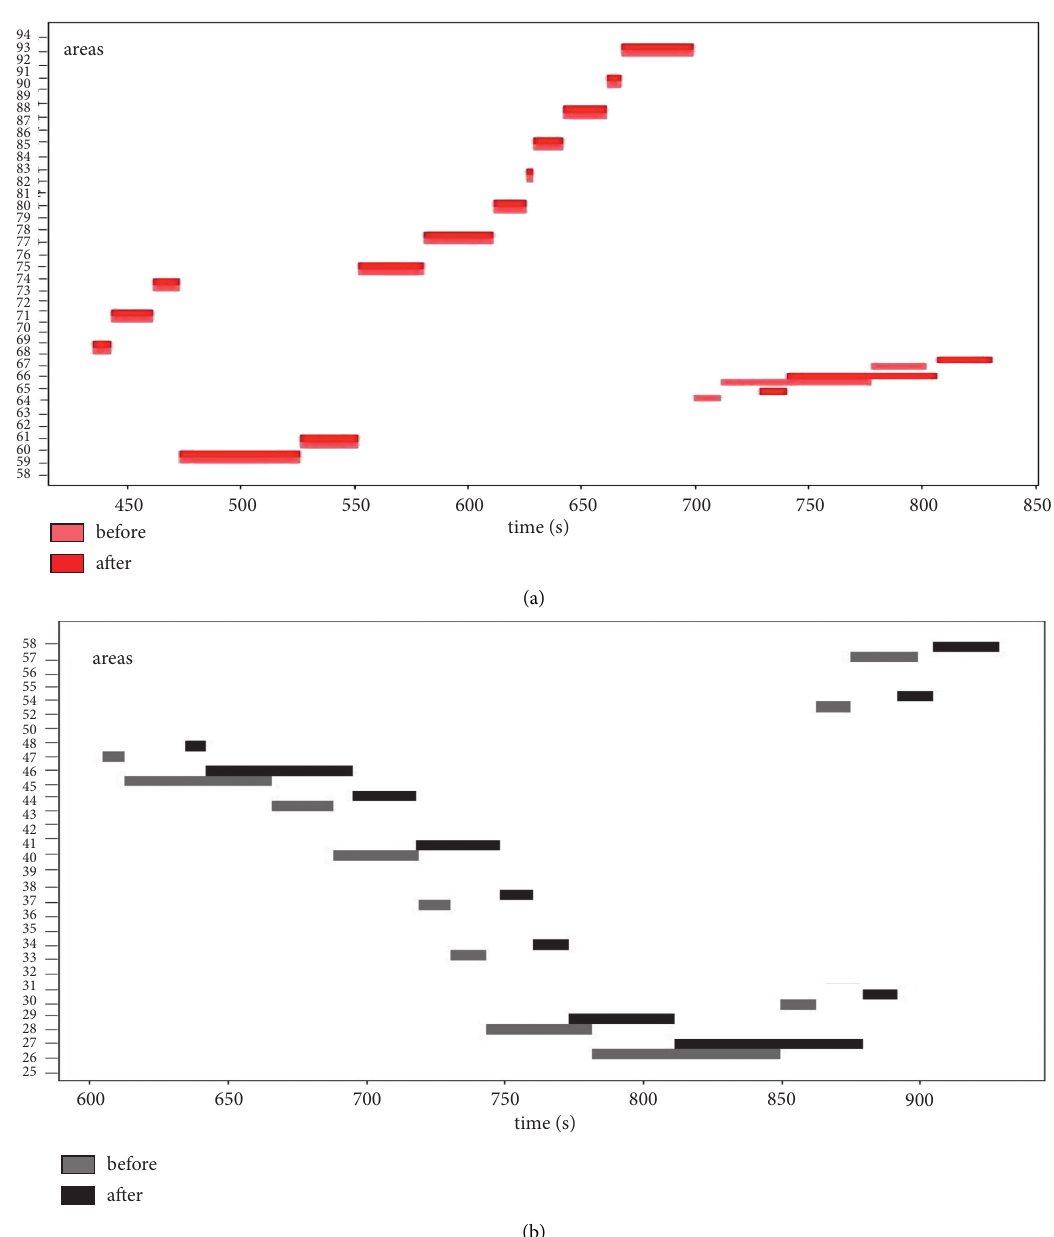
Figure 14: (a) Aircraft MU5569 area occupation time window before and after conflict resolution. (b) Aircraft HU7817 area occupation time window before and after conflict resolution. Table 3: Changes in taxi time before and after the aircraft taxi path planning (unit: second).